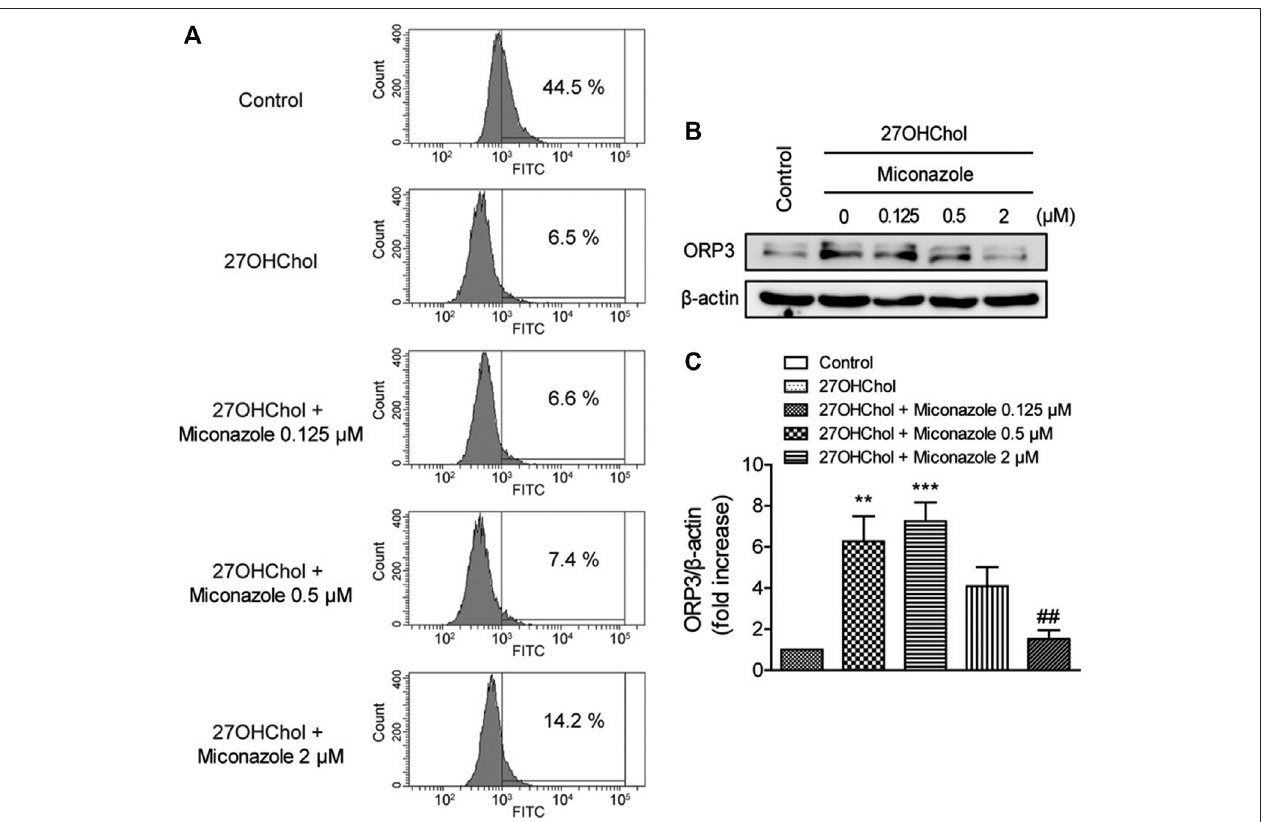
FIGURE 4 | Miconazole partially restores the endocytic function of monocytic cells. Serum-starved THP-1 cells were cultured for 48 h with 27OHChol in the presenceofindicatedmiconazoleconcentrations. (A) THP-1cellswereexposedto1 mg/mlFITC-conjugateddextranfor1 h,andthepercentageofcellsexhibitinghigh fl uorescence intensity was determined using fl ow cytometry. Data are representative of three independent experiments. (B) Isolated cell extracts were subjected to immunoblotting for β -actin and ORP3. Immunoblots are representative of three independent experiments. (C) ORP protein levels were quanti fi ed using densitometry. Dataare expressed asthe mean ± standard error (SE) ofvalues from three independent experiments. *** p < 0.001 vs control; ** p < 0.01 vs control; ## p < 0.01 vs 27OHChol. 27OHChol, 27-hydroxycholesterol.